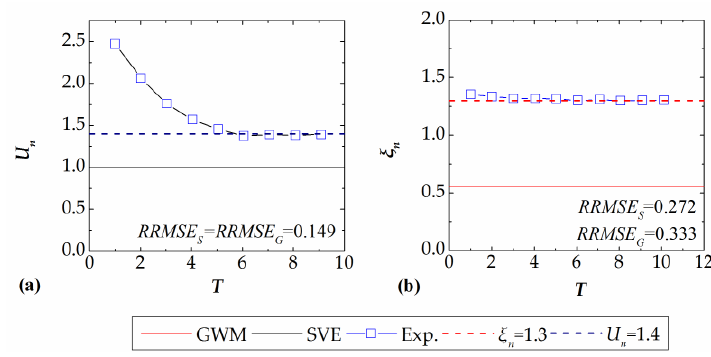
Figure 7. Velocities of ( a ) the upstream negative wave and ( b ) the downstream wave-front.